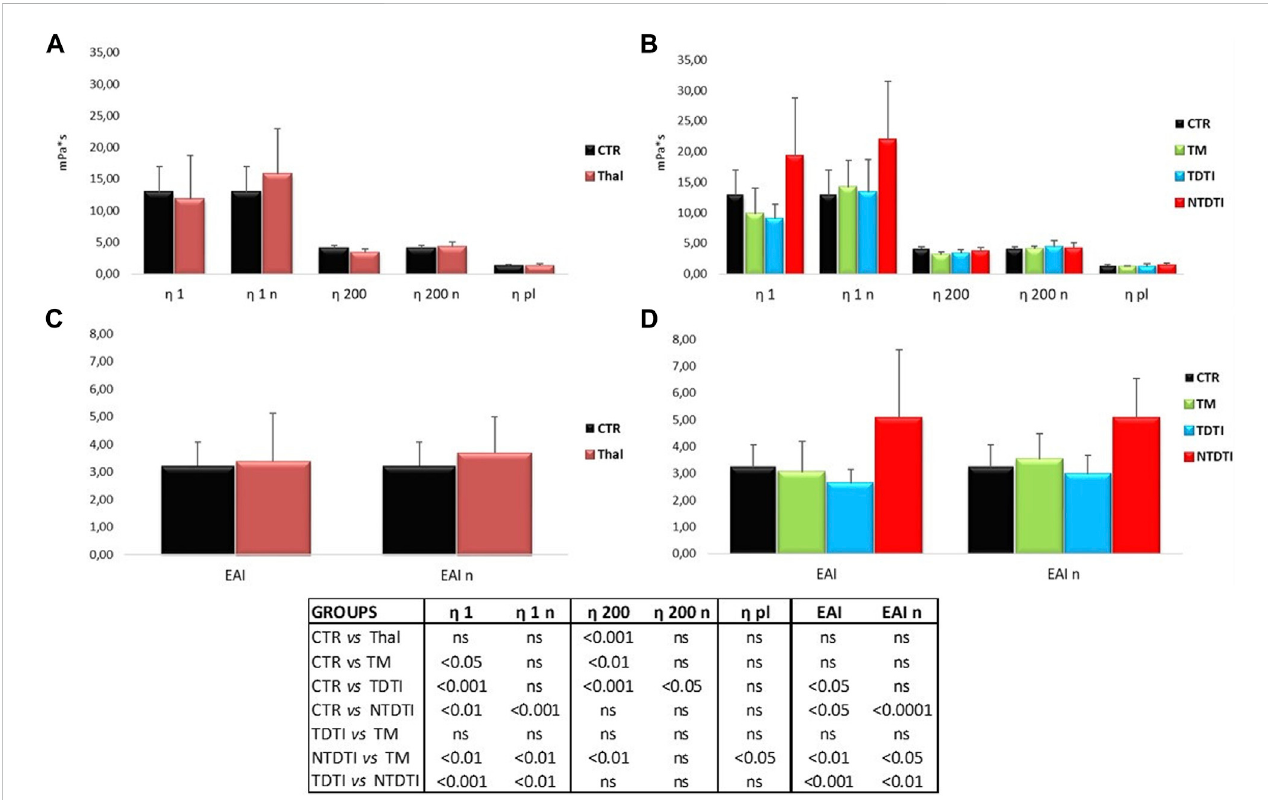
FIGURE 2 Bloodviscosities η 1and η 200,obtainedatlow(1s-1)andhigh(200s-1)shearrates,andtheerythrocyteaggregationindex(EAI)fromthalassemiapatients andhealthysubjectsdeterminedatnativeandnormalized(n)hematocrit. (A) and (C) Comparisonsbetweenhealthysubjects(CTR)andallthalassemiapatients (Thal). (B) and (D) Comparisons between CTR and patients groups divided according to the severity of the disease: TM: thalassemia major; TDTI: transfusion- dependent thalassemia intermedia; NTDTI: non-transfusion-dependent thalassemia intermedia; ns: not signi fi cant; η 1 and η 1n: native and normalized hematocrit blood viscosities at low shear rates; η 200 and η 200n: native and normalized hematocrit blood viscosities at high shear rates; EAI and EAIn determinaed at native and normalized